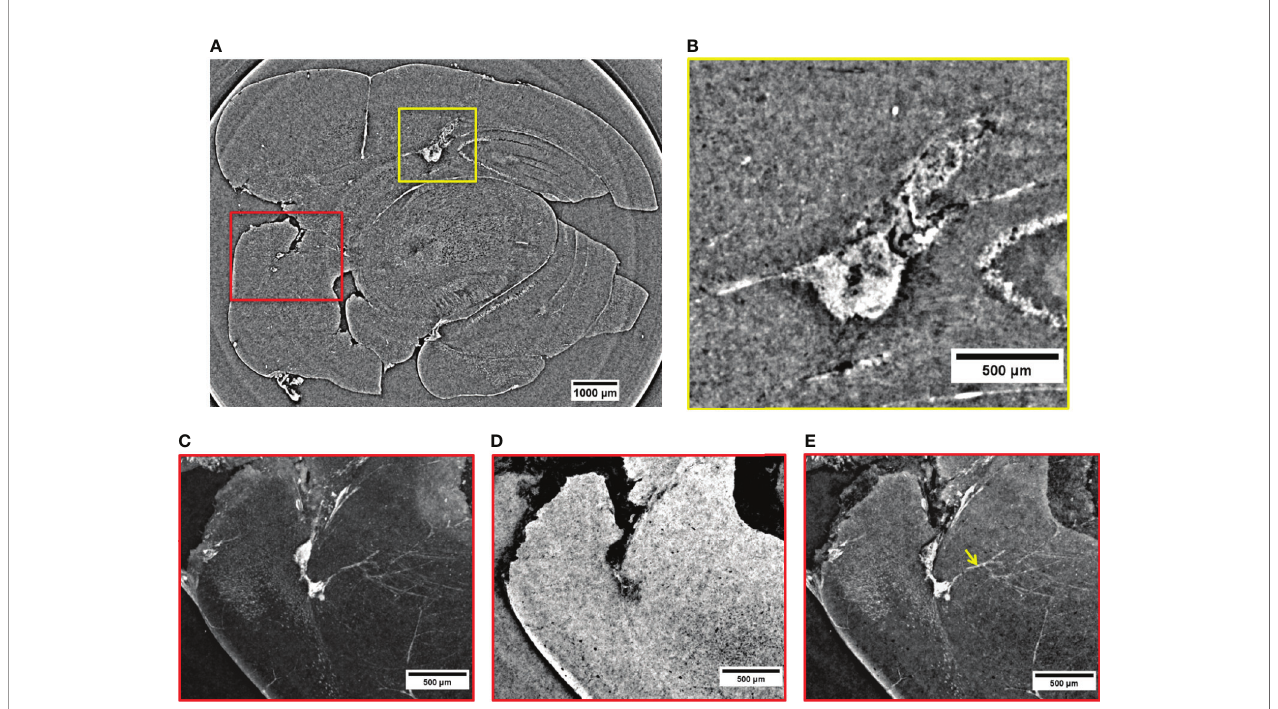
FIGURE 4 | 2D XPCT images of tumor lesions. (A) 2D XPCT slice showing two tumor lesions in a posterior structure of the brain (red box) and a metastasis developed in the lateral ventricle (yellow box). (B) Close-up visualization of the tumor invading the lateral ventricle. (C) Projection of maximum intensity values referring to the region of interest under the red box in (A) . (D) Projection of minimum intensity values referring to the region of interest under the red box in (A) . (E) Volume rendering of the same area illustrated in (A, C, D) . The image displays the accumulation of NPs in the two tumor lesions and in the neighboring vessels (pointed out by the yellow arrow).